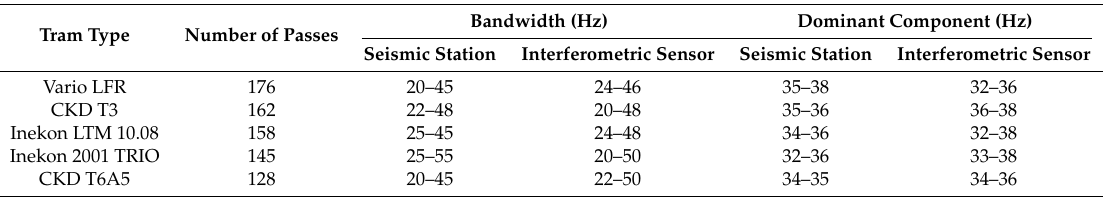
Table 3. Summary of the results of measured frequencies from both devices with regard to the type of